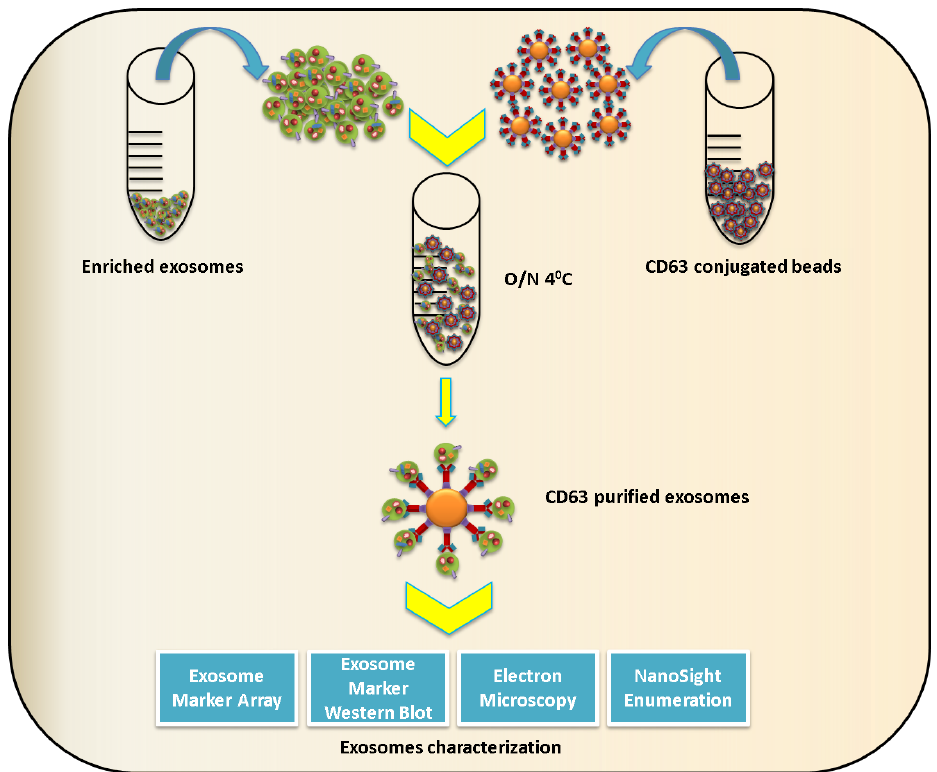
Figure 4. Schematic representation of exosome immune-isolation. To obtain exosomes free of contaminants, exosomes can be subjected to immunomagnetic selection using anti-CD63 antibody conjugated beads and then characterized by immunoblot, electron microscopy, and size determination.